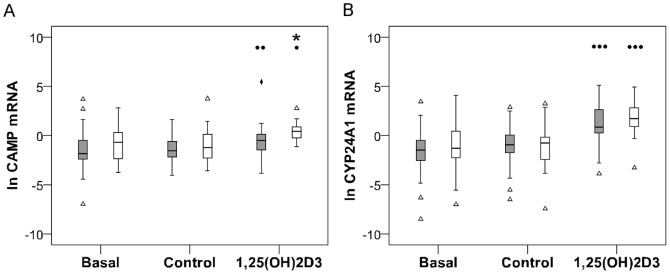
1,25(OH)2D3-elicited transactivation of target gene CAMP by VDR is influenced by ethnicity.Box plots illustrate expression of VDR target genes, CAMP (A) and CYP24A1 (B). Data is differentiated by ethnicity: Africans (grey, n = 40) and Whites (white, n = 20). Gene expression was quantified in monocyte-macrophages from healthy individuals using RT-qPCR. In vitro 1,25(OH)2D3 supplementation significantly induced CAMP and CYP24A1 expression in both Africans and Whites relative to the vehicle control level (P<.050, P<0.010, P<0.001). Ethnicity had a significant main effect on CAMP (P<0.010), but not CYP24A1 mRNA level. Significantly higher mean CAMP mRNA level was observed in Whites compared to Africans after 1,25(OH)2D3 supplementation (* P<0.050). CAMP and CYP24A1 mRNA data was ln-transformed to meet the assumptions of parametric statistical analysis. Outliers are defined in legend for Fig. 1.